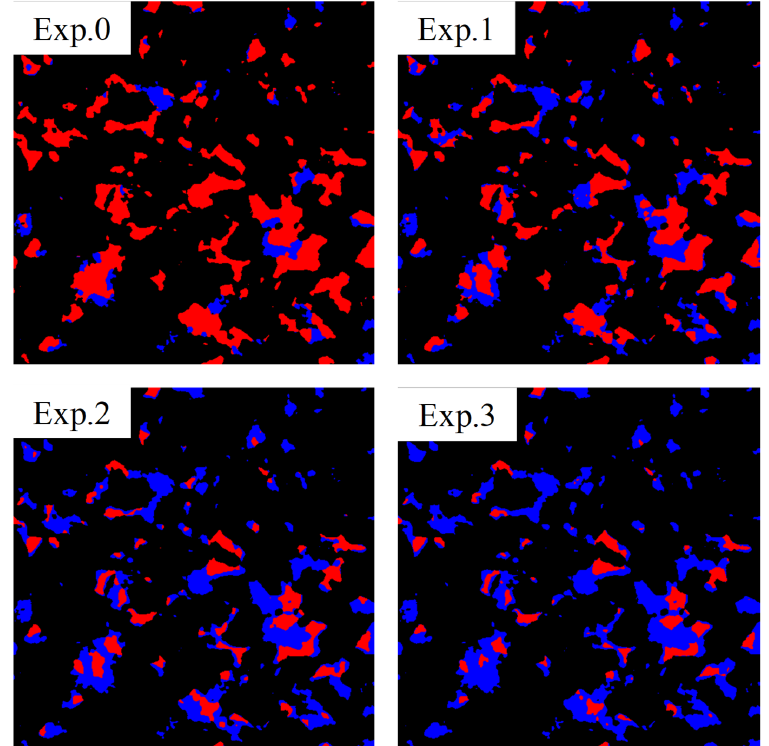
Figure 10. Two-dimensional cross-section views of the fluid occupancy in different stages (red represents oil; blue represents water; black represents grain).